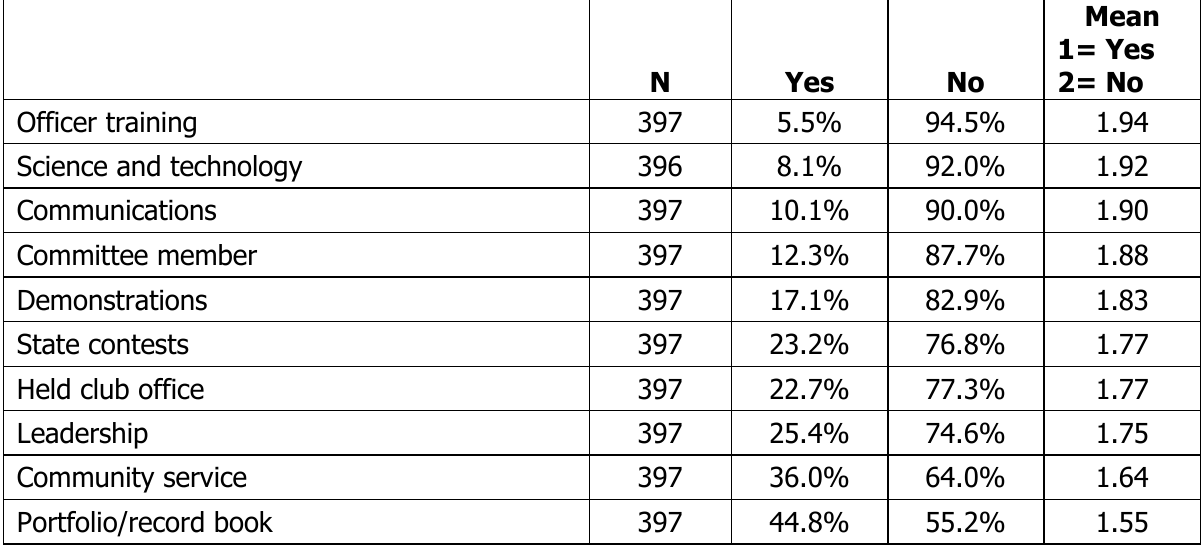
Activities 4-H and FFA Youth Have Participated In (ranked in ascending